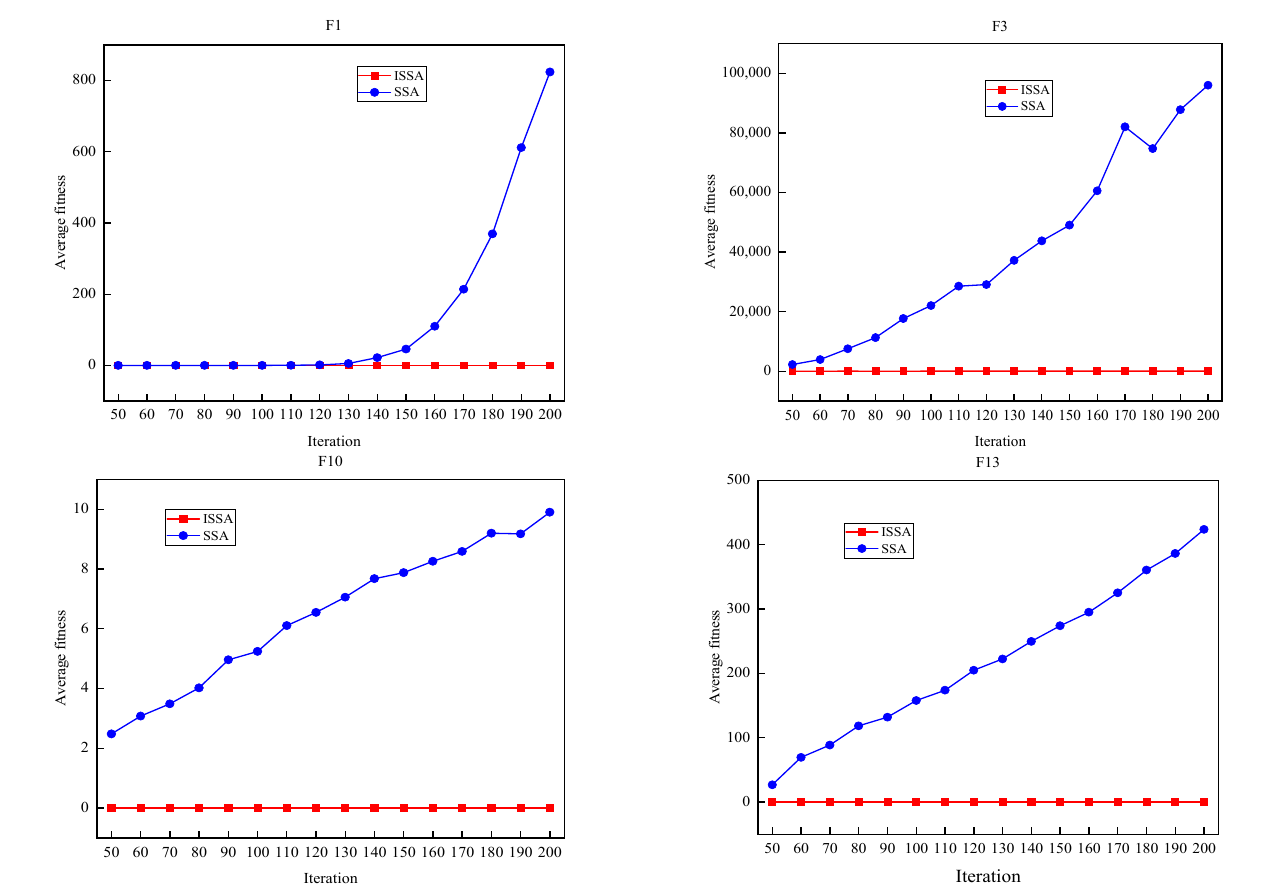
Figure 7. Results of scalability test on four selected benchmark functions (F1, F3, F10, and F13) for ISSA.